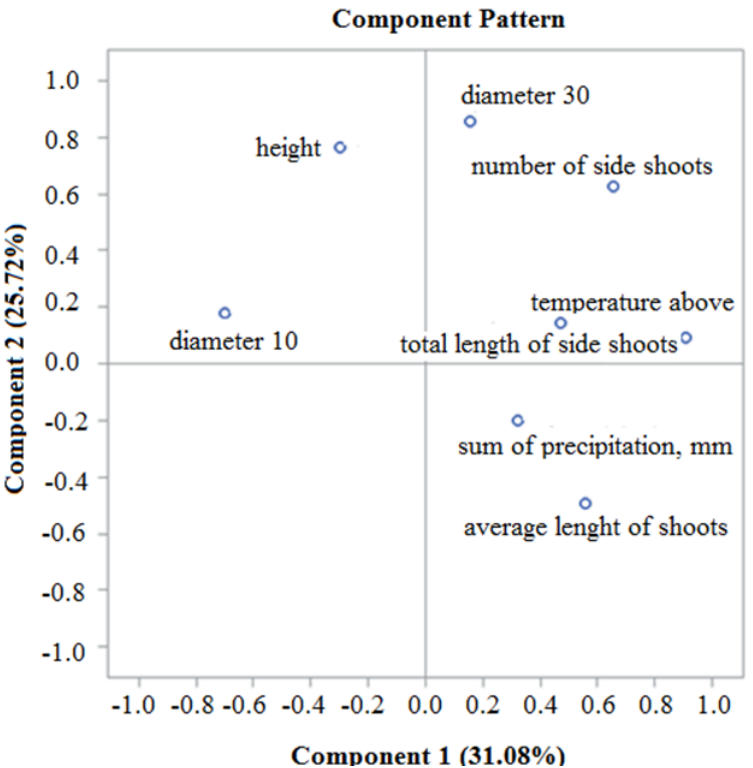
Figure 5. The PCA map shows the relationship between the value of the assessed growth parame- ters and quality of ‘ Gala Must ’ apple trees depending on weather conditions. and quality of ‘Gala Must’ apple trees depending on weather